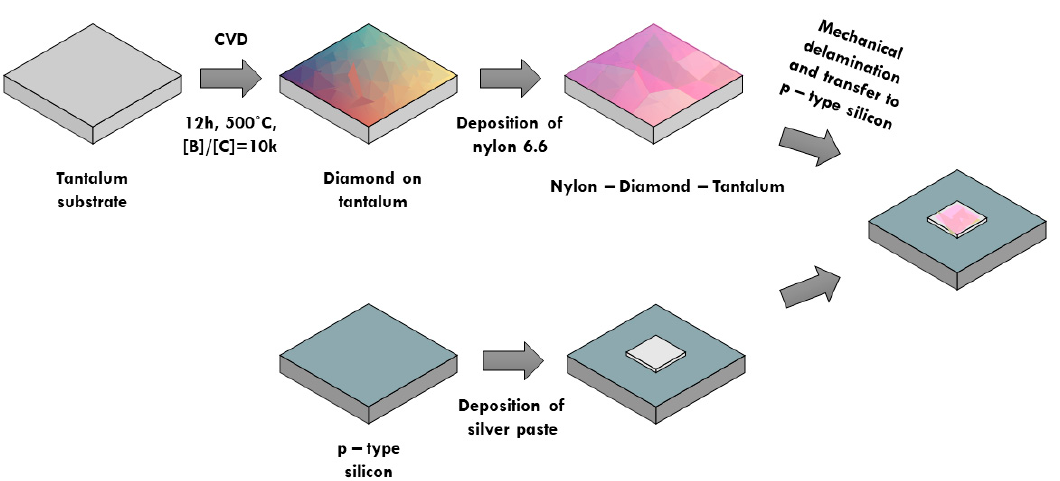
Figure 2. Procedure for the fabrication of nylon-coated, boron-doped, diamond nanosheet samples for nanoindentation test.